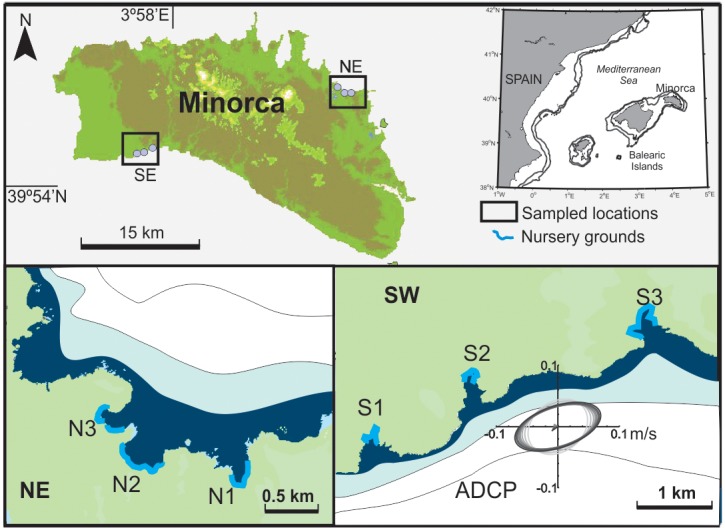
Study sites.The two distinct sampling locations at the Northeast (NE) and Southwest (SW) of the Menorca Island and the six coves monitored during the study. The Acoustic Doppler Current Profiler (ADCP) localization and the current variation ellipses measured at different depths (darker is shallower) are also indicated at the SW site. Maps were created by the authors by merging topographical maps generated with ArgGIS using IDEIB terrain elevation model (http://ideib.caib.es/visualitzador/visor.jsp) and the MATLAB software. There are no copyright restrictions associated and permissions for publication are not necessary.